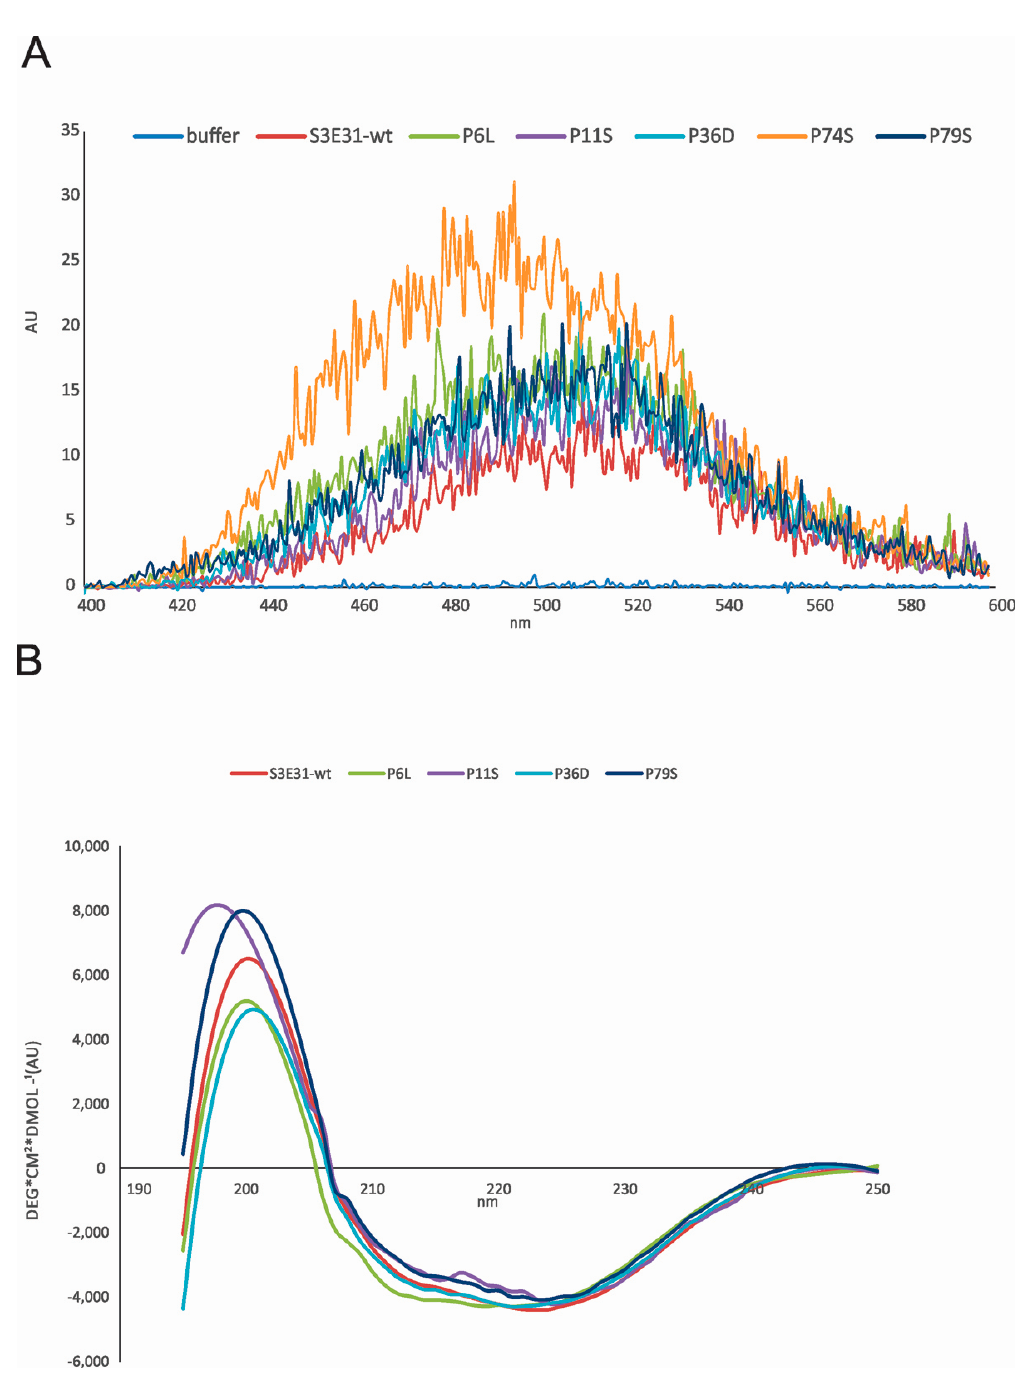
Figure 3. ( A ) ANS fluorescence upon binding to wild-type protein (wt) stefin B and proline mutants. The excitation wavelength was 370 nm, and the spectra were recorded from 400 nm to 600 nm on a Perkin Elmer LS50B (Perkin Elmer, Waltham, MA, USA). Slits were open 2.5 nm. ANS was dissolved in 0.01 M phosphate buffer, pH 7, and 0.15 M NaCl. Final concentrations were 1.25 mM ANS and 25 µM proteins; ( B ) Far UV CD spectra of wt stefin B and proline mutants were recorded from 195 to 250 nm, as indicated. The bandwidth was 1 nm and spectra recording time at each nm was 3 s; the temperature was 25 °C. Final concentrations were 34 µM. Due to high aggregation propensity, the final concentrations varied. Therefore, ellipticity values were normalized to the wt spectrum (i.e., a factor was used to give ellipticity—4200 ± 100 deg·cm 2 ·dmol − 1 ). SEC data on the wt and its proline mutants show (Supplementary Figure S3) that dimers are the main oligomeric form of the wt stefin B and P36D mutant—when frozen and unfrozen once. The amount of the higher oligomers increases upon freeze-thawing. Then come the tetramers and higher